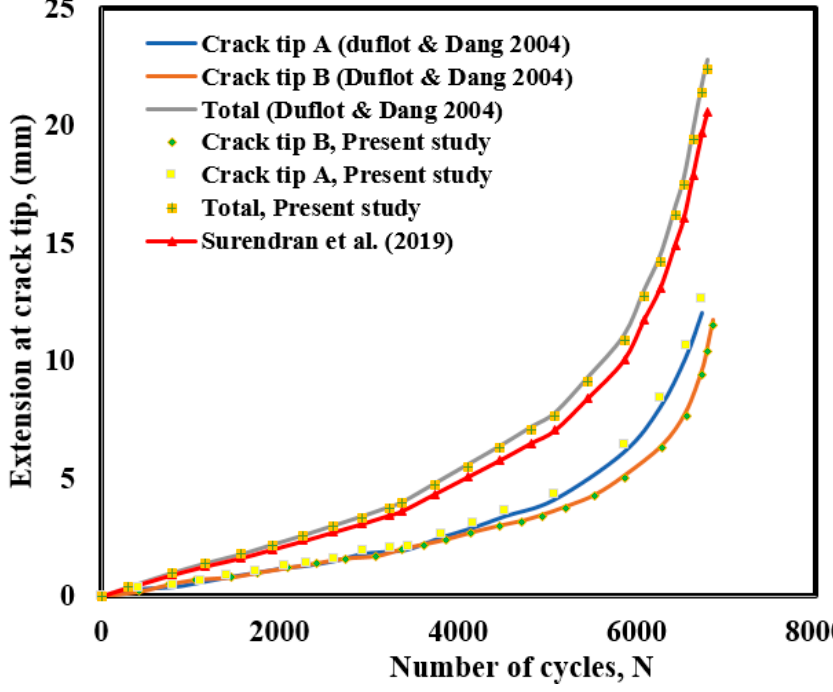
Figure 7. Comparison for the fatigue lifecycles for the two internal non-colinear cracks.